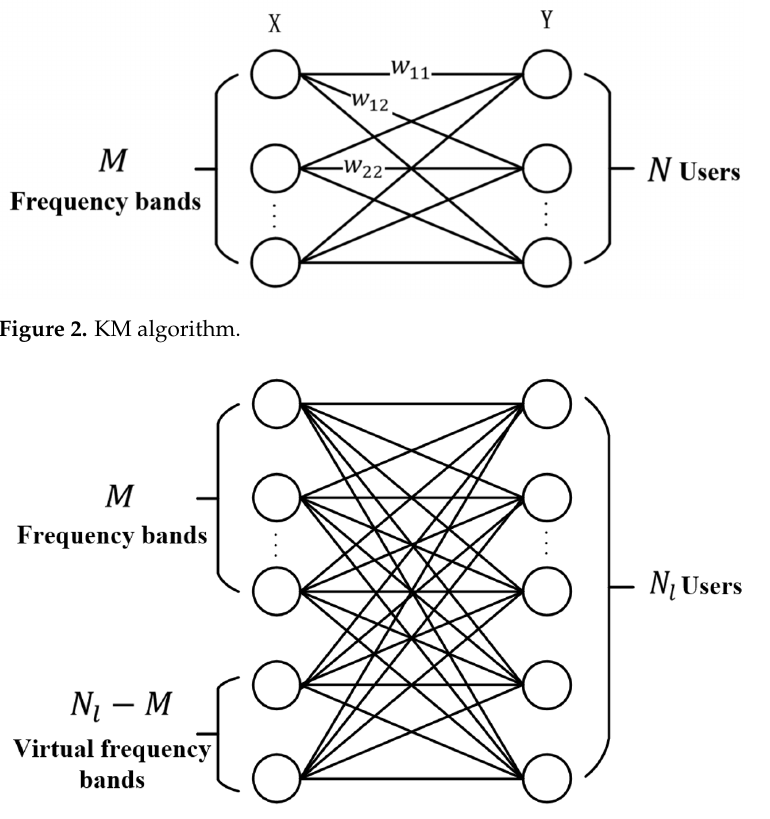
Figure 3. Multi-stage KM